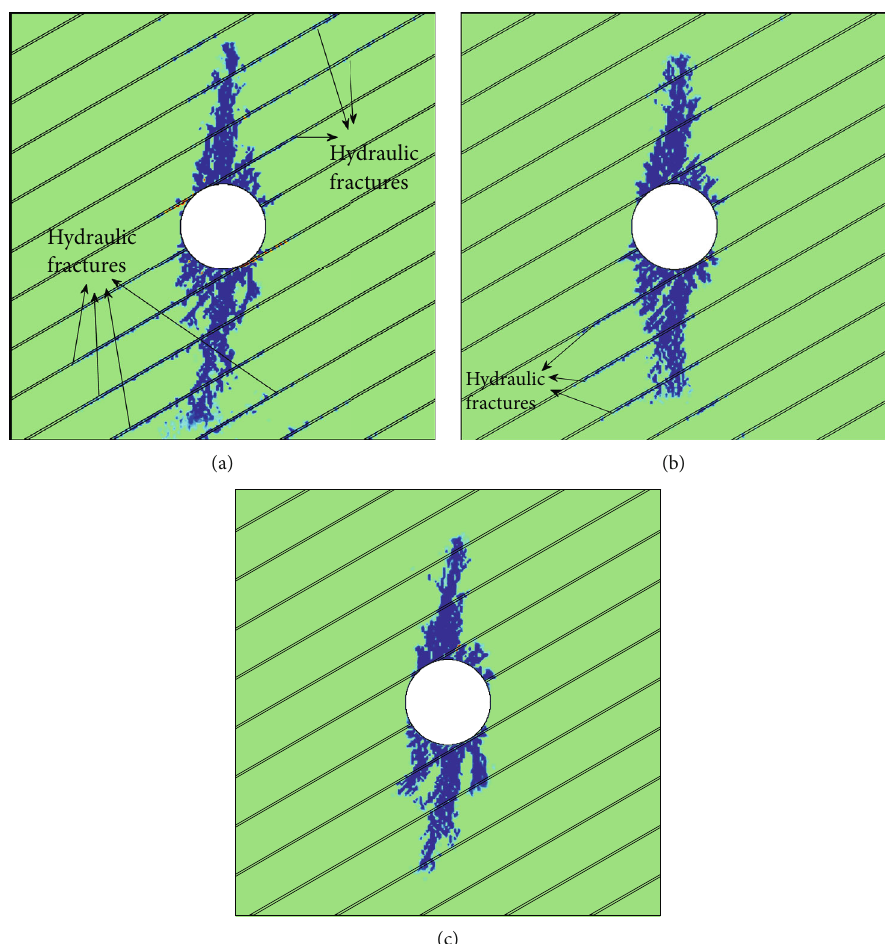
/ E = 0 : 1 , (b) E / 1 2 1